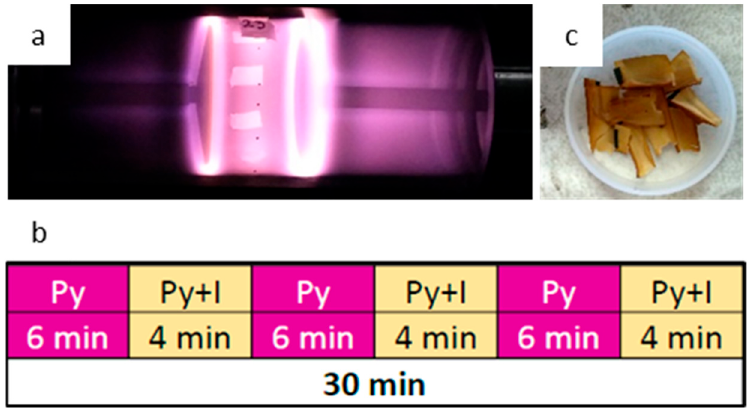
Figure 1. Pyrrole plasma polymer synthesis. Reactor chamber containing electrospun samples ( a ); monomer/dopant supply scheme ( b ) and resulting coated scaffolds ( c ).